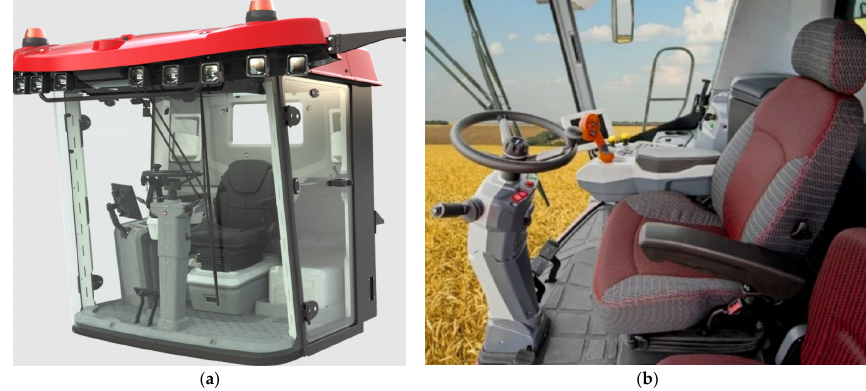
Figure 1. Harvester cabin: ( a ) outside; ( b ) inside.